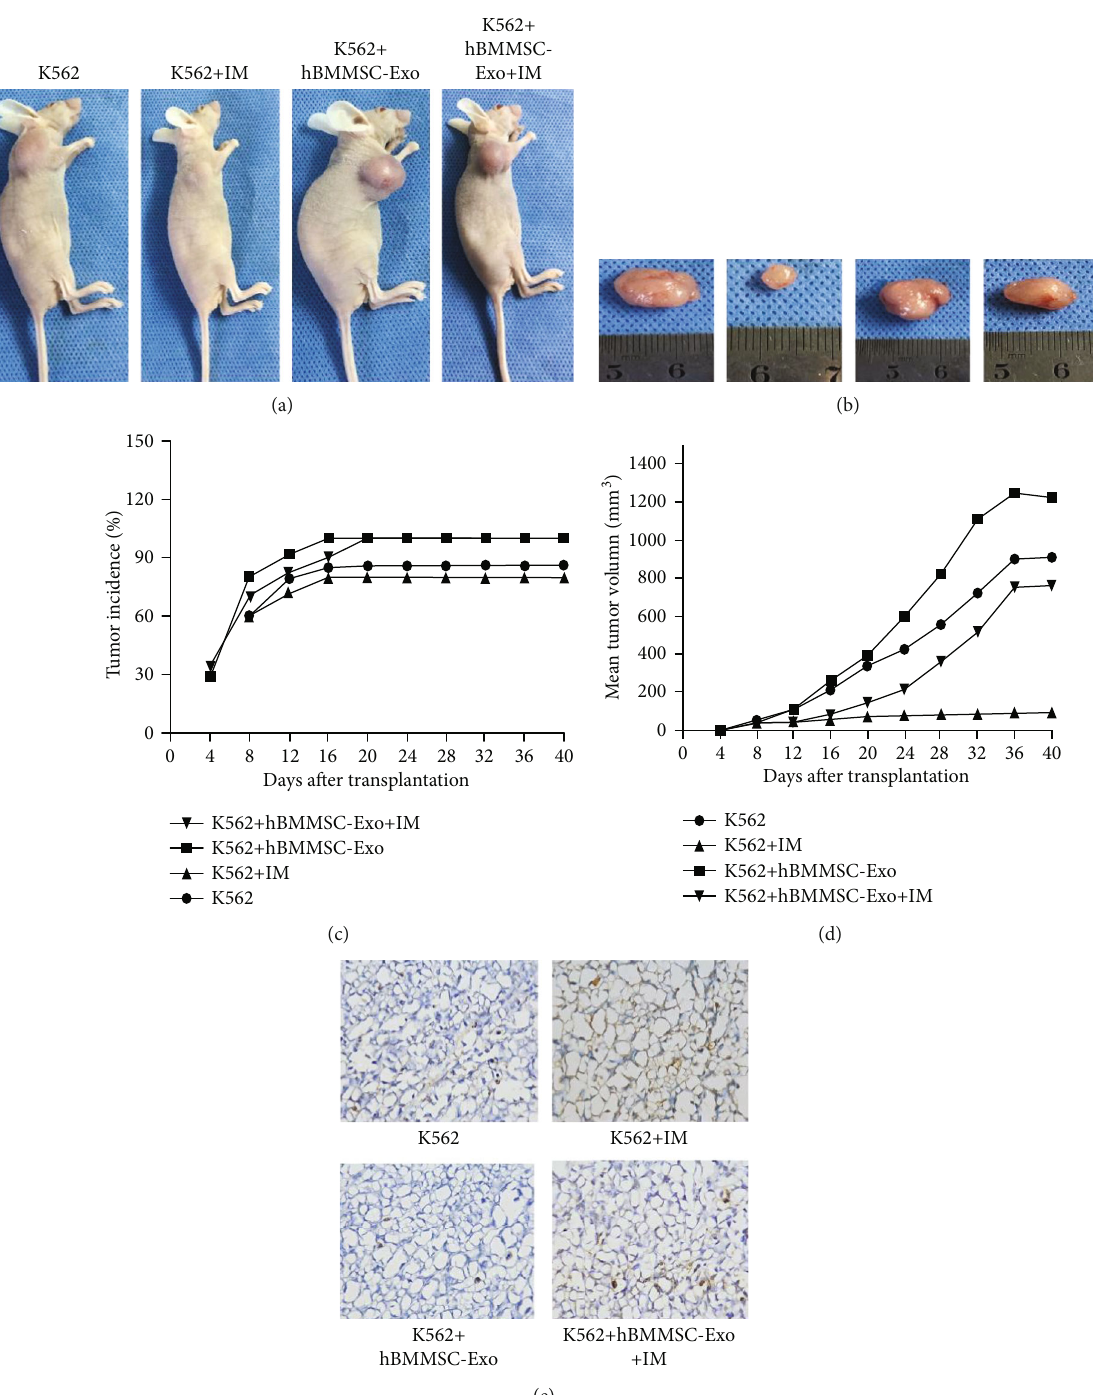
Figure 6: hBMMSC-Exo promote tumor growth in vivo. (a) Representative example of BALB/c-nu mice after transplantation with K562 cells and hBMMSC-Exo by subcutaneous injection. (b) Gross observation of the isolated tumors on day 40 after implantation. (c) Tumor incidence. hBMMSC-Exo signi fi cantly increased the tumor incidence. (d) Tumor growth curves. Tumor growth was faster in group K562 cells mixed with hBMMSC-Exo. (e) Representative micrographs of TUNEL staining. The data were expressed as the mean ± SD of the three independent experiments. ∗ p < 0 : 05 Student ’ s